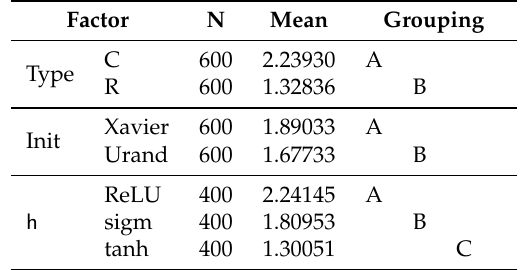
Table 5. Tukey pairwise comparison 3-way ANOVA for the activation functions comparison ( M = 8). Grouping information using the Tukey test and 95% confidence. Means that do not share a letter are significantly different